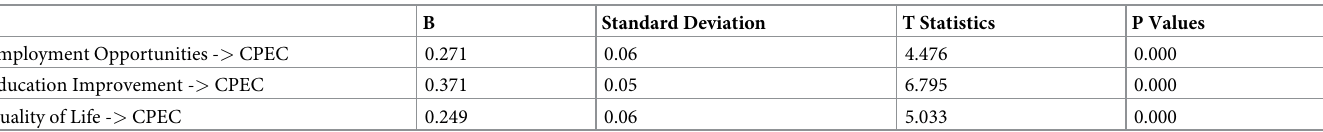
Table 7. PLS bootstrapping.